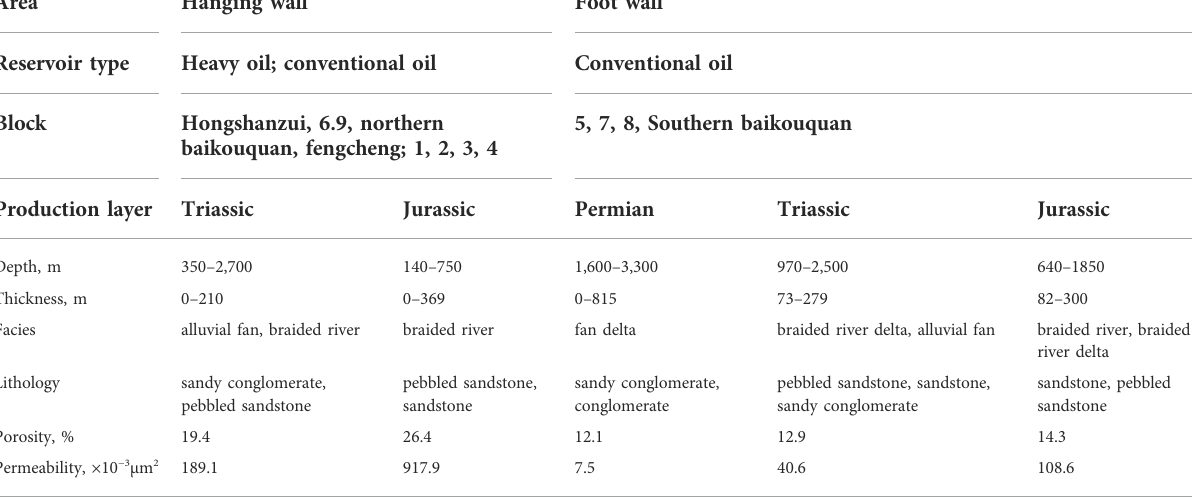
(Figure 1). The geological factors are similar within the same block and vary from block to block. Affected by the long-term activities of the thrust faults, the buried depths of the contemporaneous strata in the hanging wall and the foot wall are quite different. The Permian, lower Triassic and lower Jurassic strata of the hanging wall were eroded in different degrees, while the strata of the foot wall were completely developed and deeply buried (Table